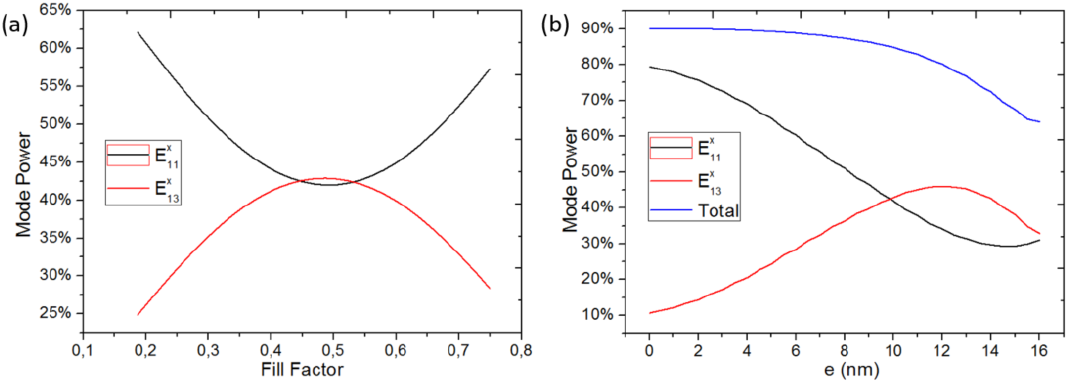
Figure 7. Change in the mode power with increasing fill factor ( a ) and modulation depth, e ( b ).